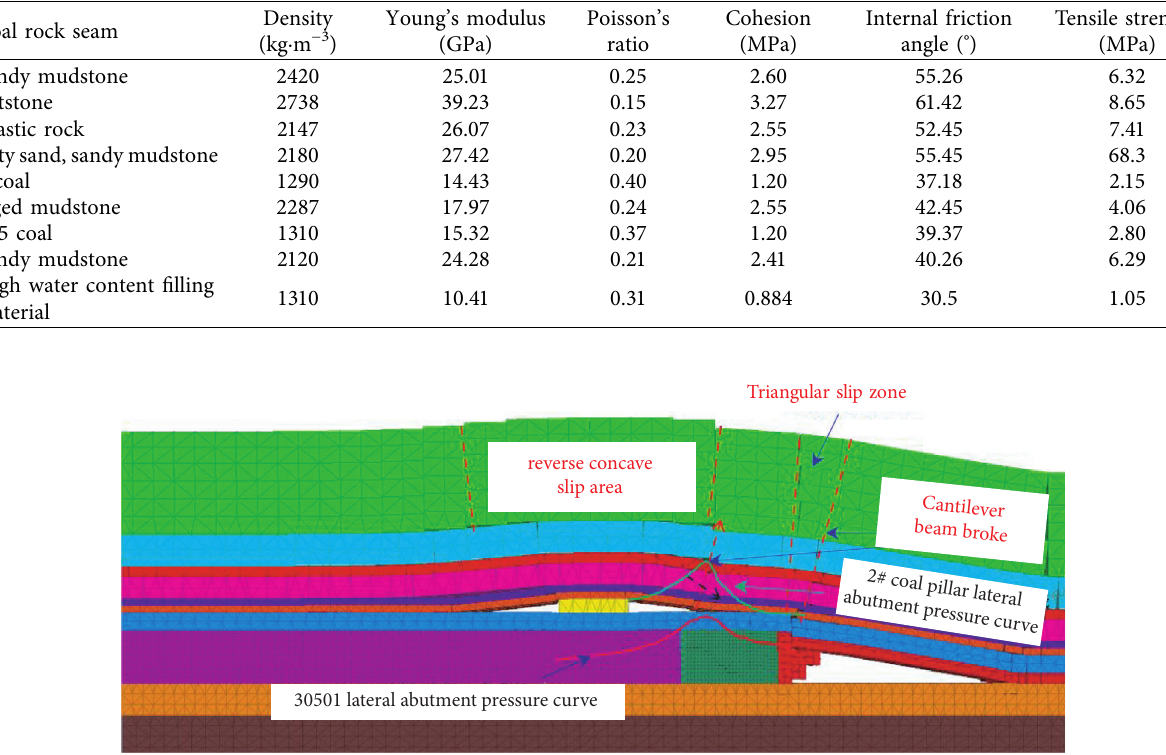
Figure 7: Migration of overlying rock during formation of 2# coal and 30501